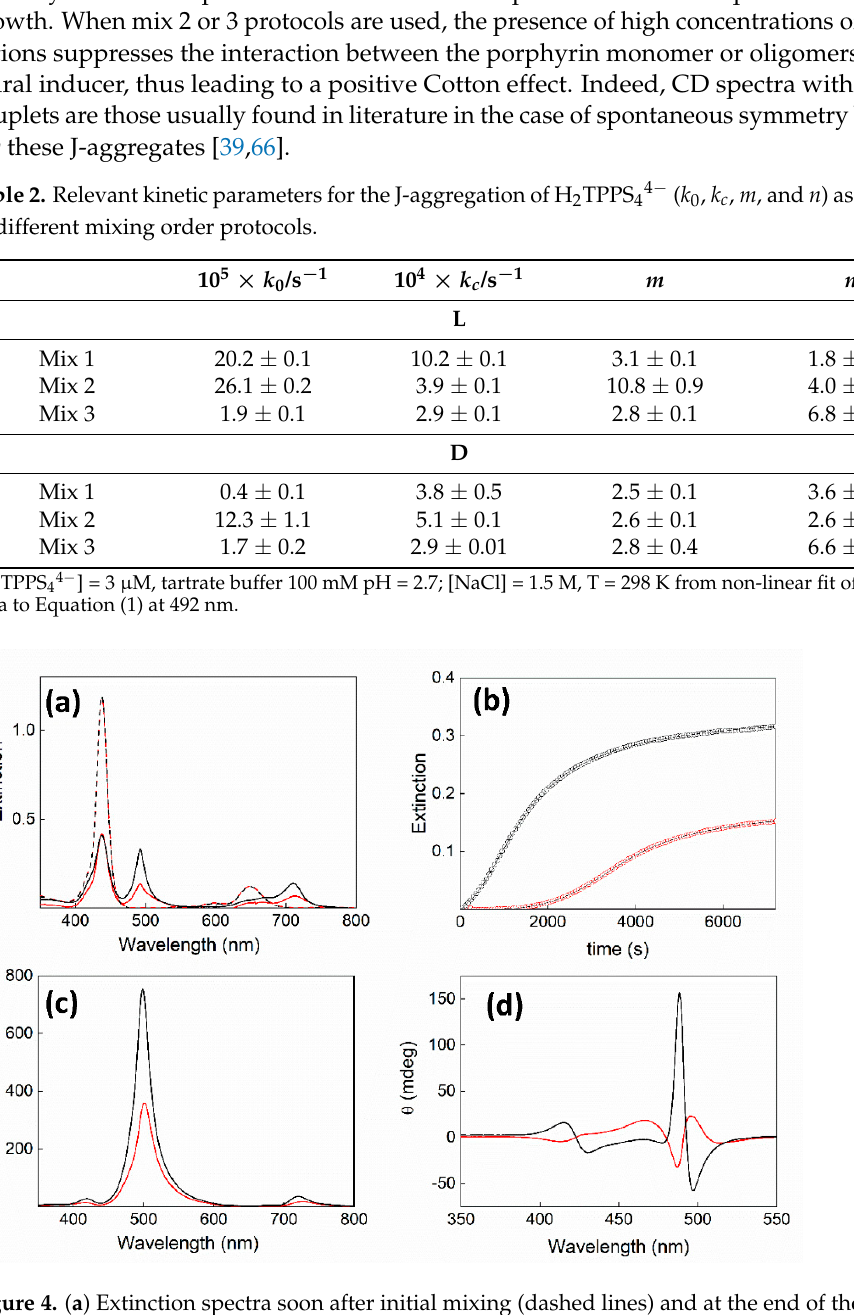
Figure 5. ( a ) Extinction spectra before (dotted line), soon after initial mixing (dashed lines), and at the end of the aggrega- tion (solid lines), ( b ) kinetic extinction time traces at λ = 492 nm (solid lines show the best fit of the experimental data according to Equation (1)), ( c ) RLS, and ( d ) CD spectra for the supramolecular assembling of H 2 TPPS 44- induced by salt and tartrate buffer (L: black lines; D: red lines) using mix 2 protocol. Experimental conditions: [H 2 TPPS 44- ] = 3 μ M; [NaCl] = 1.5 M; tartrate buffer 100 mM, pH 2.7, T = 298 K.